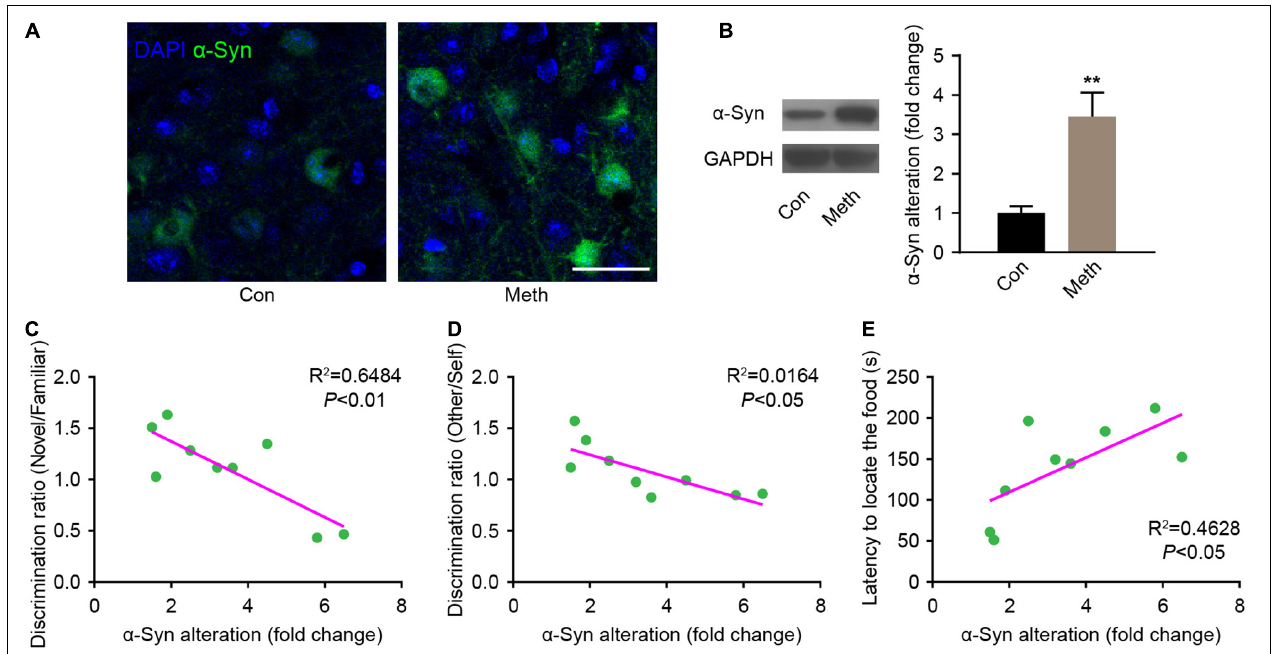
FIGURE 3 | Chronic methamphetamine administration increases the expression of α -syn in the olfactory bulb. (A) Representative confocal immunofluorescence images of the OB mitral cells stained for α -syn (Green) upon chronic methamphetamine administration. Scale bar, 20 µ m. (B) The levels of α -syn were examined by western blotting ( n = 9). t = 3.895 by unpaired t test. GAPDH served as a normalization control. The correlation between α -syn expression changes and olfactory discrimination (C) , social olfactory discrimination (D) and buried food test (E) results was analyzed in chronic methamphetamine-administered mice, and there was a significant association between α -syn changes and behavioral alterations ( n = 9). Data are presented as mean ± SEM. ** P <